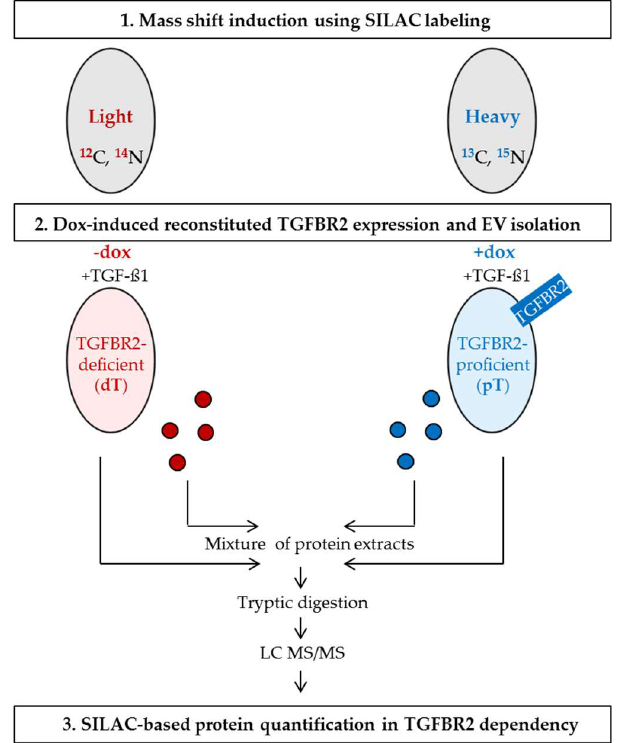
Figure 1. Transforming Growth Factor Beta Receptor Type 2 (TGFBR2)-dependent protein quantification using stable isotope labeling with amino acids in cell culture (SILAC). HCT116-TGFBR2 cells were labeled with light ( red ) or heavy ( blue ) amino acids. The mass shift induction was performed over a period of 14 days. Heavy-labeled cells were treated with dox to induce reconstituted expression of TGFBR2 (heavy state: TGFBR2-proficient, pT). Light-labeled cells were cultivated in the absence of dox and remained TGFBR2-deficient (light state: TGFBR2-deficient, dT). The SILAC experiment was performed in triplicate. Extracellular vesicles (EVs) were isolated and characterized from both conditions. Protein extracts from EVs and their parental cells were mixed separately and prepared for high-resolution mass spectrometry analysis. “Light-to-heavy” (dT / pT) protein ratios were calculated in order to identify proteins regulated in a TGFBR2-dependent manner.